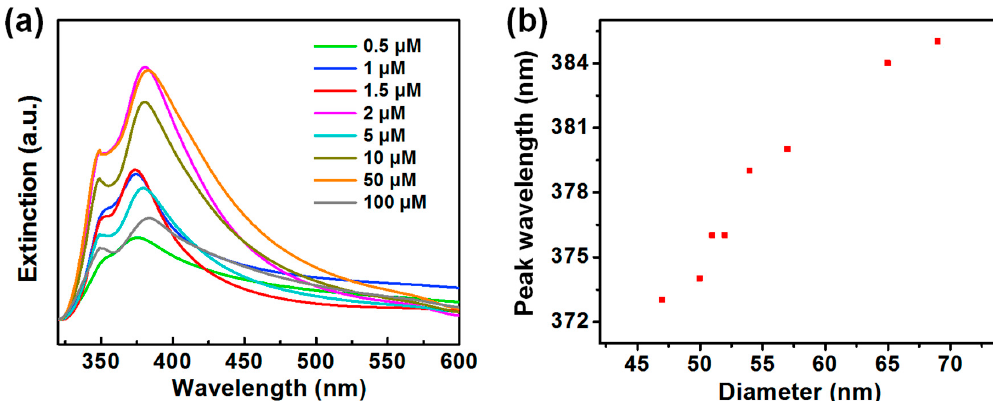
Figure 5. ( a ) UV-vis absorption spectra of products synthesized with 600 µ M of NaCl, 100 µ M of NaBr and di ff erent additions of Fe(NO 3 ) 3 . ( b ) The quantitative statistics of the relationship between the strong absorption peak and AgNW diameter.